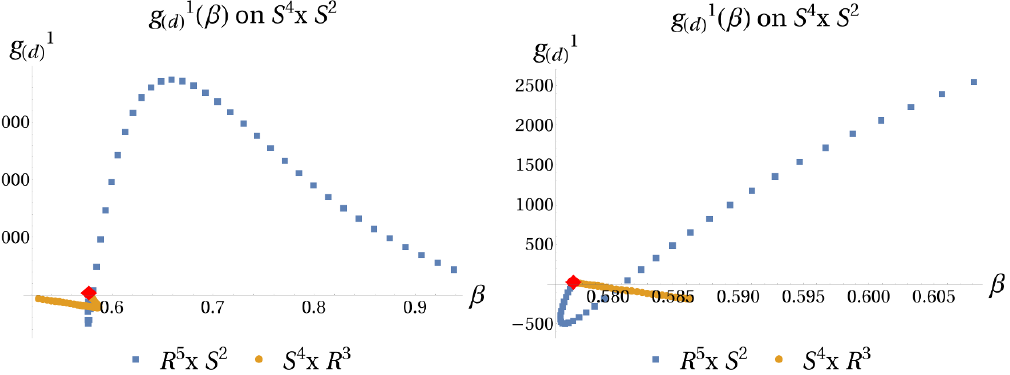
Figure 13 . g 1 as a function of the ratio of radii (cid:12) for both topologies with conformal boundary ( d ) S 4 (cid:2) S 2 . This is proportional to the expectation value of the energy-momentum tensor. The red diamond is the analytical calculation for the singular ratio (cid:12) s